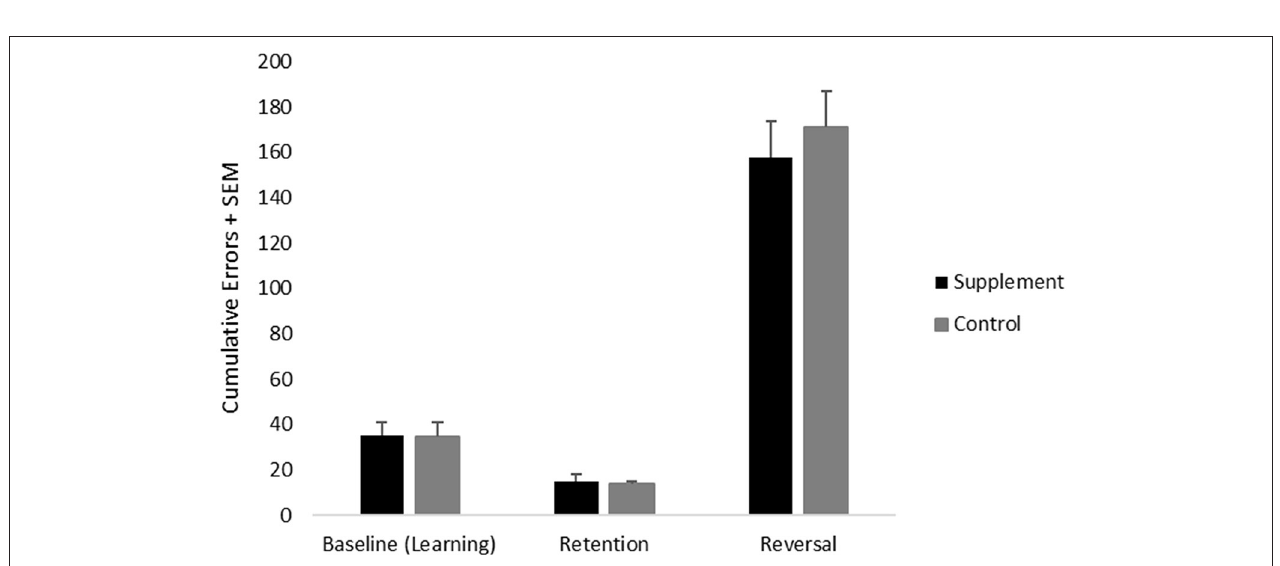
FIGURE 3 | Mean cumulative errors on discrimination learning (performed at baseline) as well as retention and reversal tasks (both performed during the treatment phase) across treatment